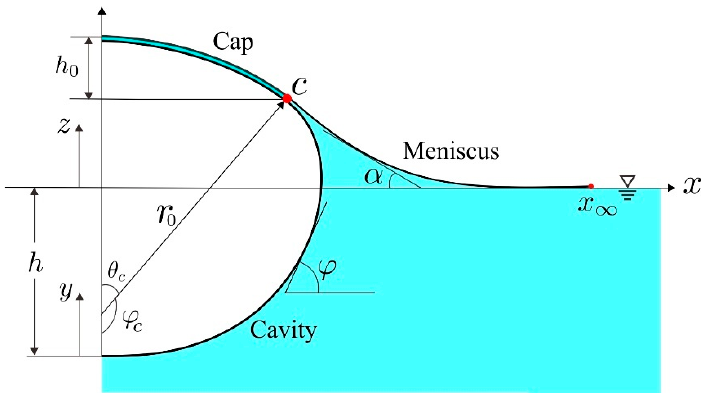
Figure 1. The schematic configuration of a floating bubble.